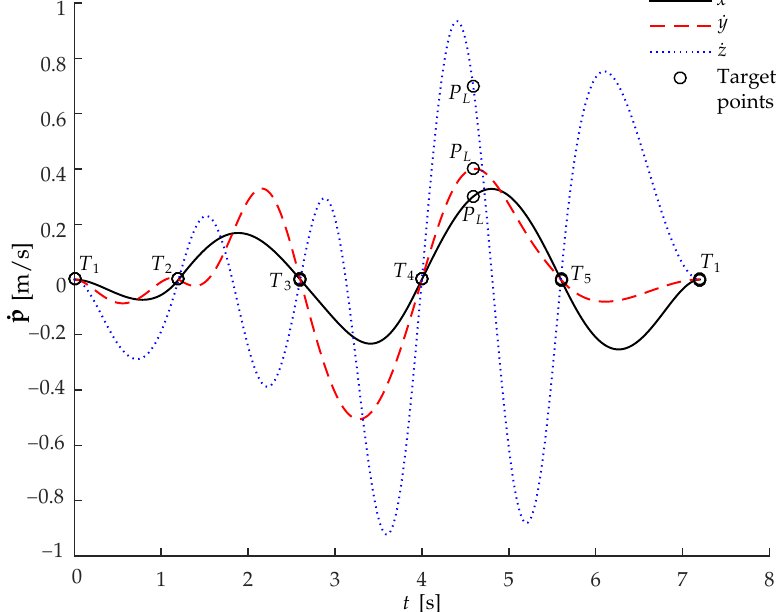
Figure 9. Plot of the velocity components of P , for the Bézier curve trajectory.